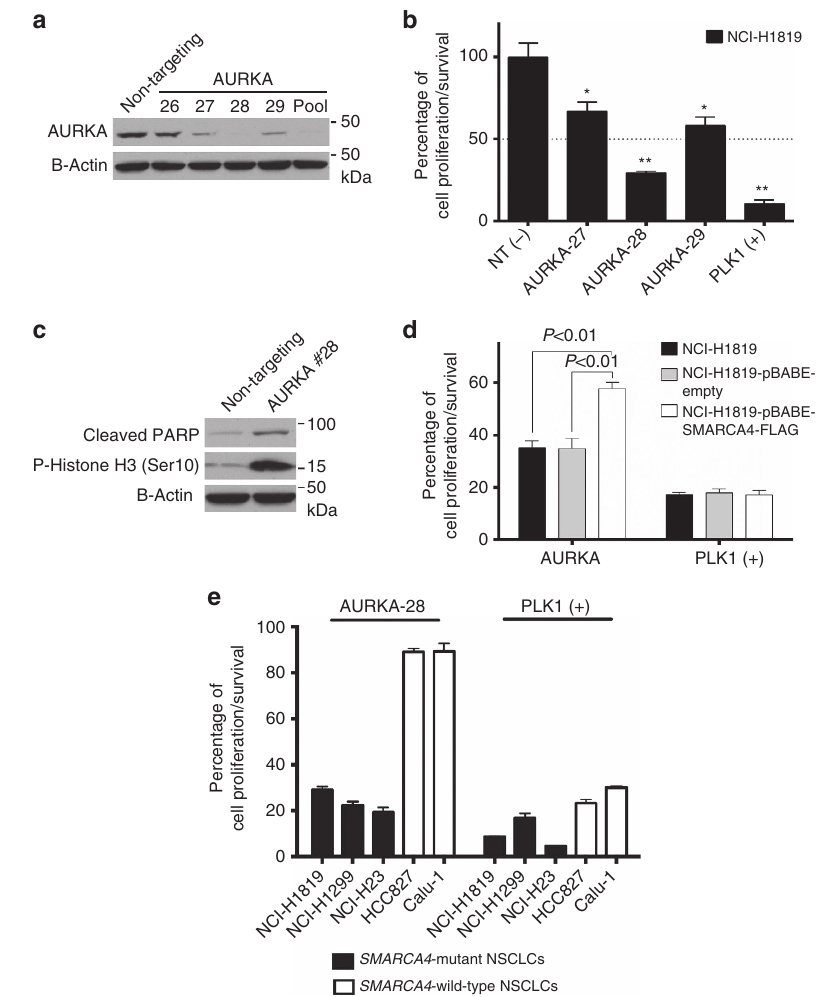
Figure 3 | Loss of SMARCA4 expression in NCI-H1819 increases toxicity of siRNAs to AURKA. ( a ) NCI-H1819 cell lysates were collected 3 days after transfecting the cells with either non-targeting or AURKA-targeting siRNAs and were immunoblotted to monitor AURKA protein levels. ( b ) Five days after transfecting NCI-H1819 cells with individual siRNAs, cell viability was measured with a CellTiter-Glo assay on triplicate biological replicates. PLK1 knockdowns were used as the positive control. Means with s.d. are shown on the graphs. * indicates statistical significance ( P o 0.001) and ** indicates statistical significance ( P o 0.001) combined with higher biological significance (viability o 50%). ( c ) The response to depletion of AURKA was assessed by immunoblotting with monoclonal antibodies to cleaved PARP, phospho-Histone H3 and b -Actin. ( d ) Five days after depleting AURKA in NCI-H1819, NCI-H1819-pBABE and NCI-H1819-pBABE-SMARCA4-FLAG cells, cell viability was measured with a CellTiter-Glo assay as in part ( b ). ( e ) Five days after transfecting NCI-H1819, NCI-1299, NCI-H23, HCC827 and Calu-1 cells with non-targeting or individual siRNA #28 targeting AURKA, cell viability was measured with a CellTiter-Glo viability assay as in Fig. 2. PLK1 was depleted as the positive control. Error bars on graphs are s.d. of means from triplicate biological replicates. Statistical significance on graphs was assessed by one-way ANOVA and post hoc Dunnett’s multiple comparison